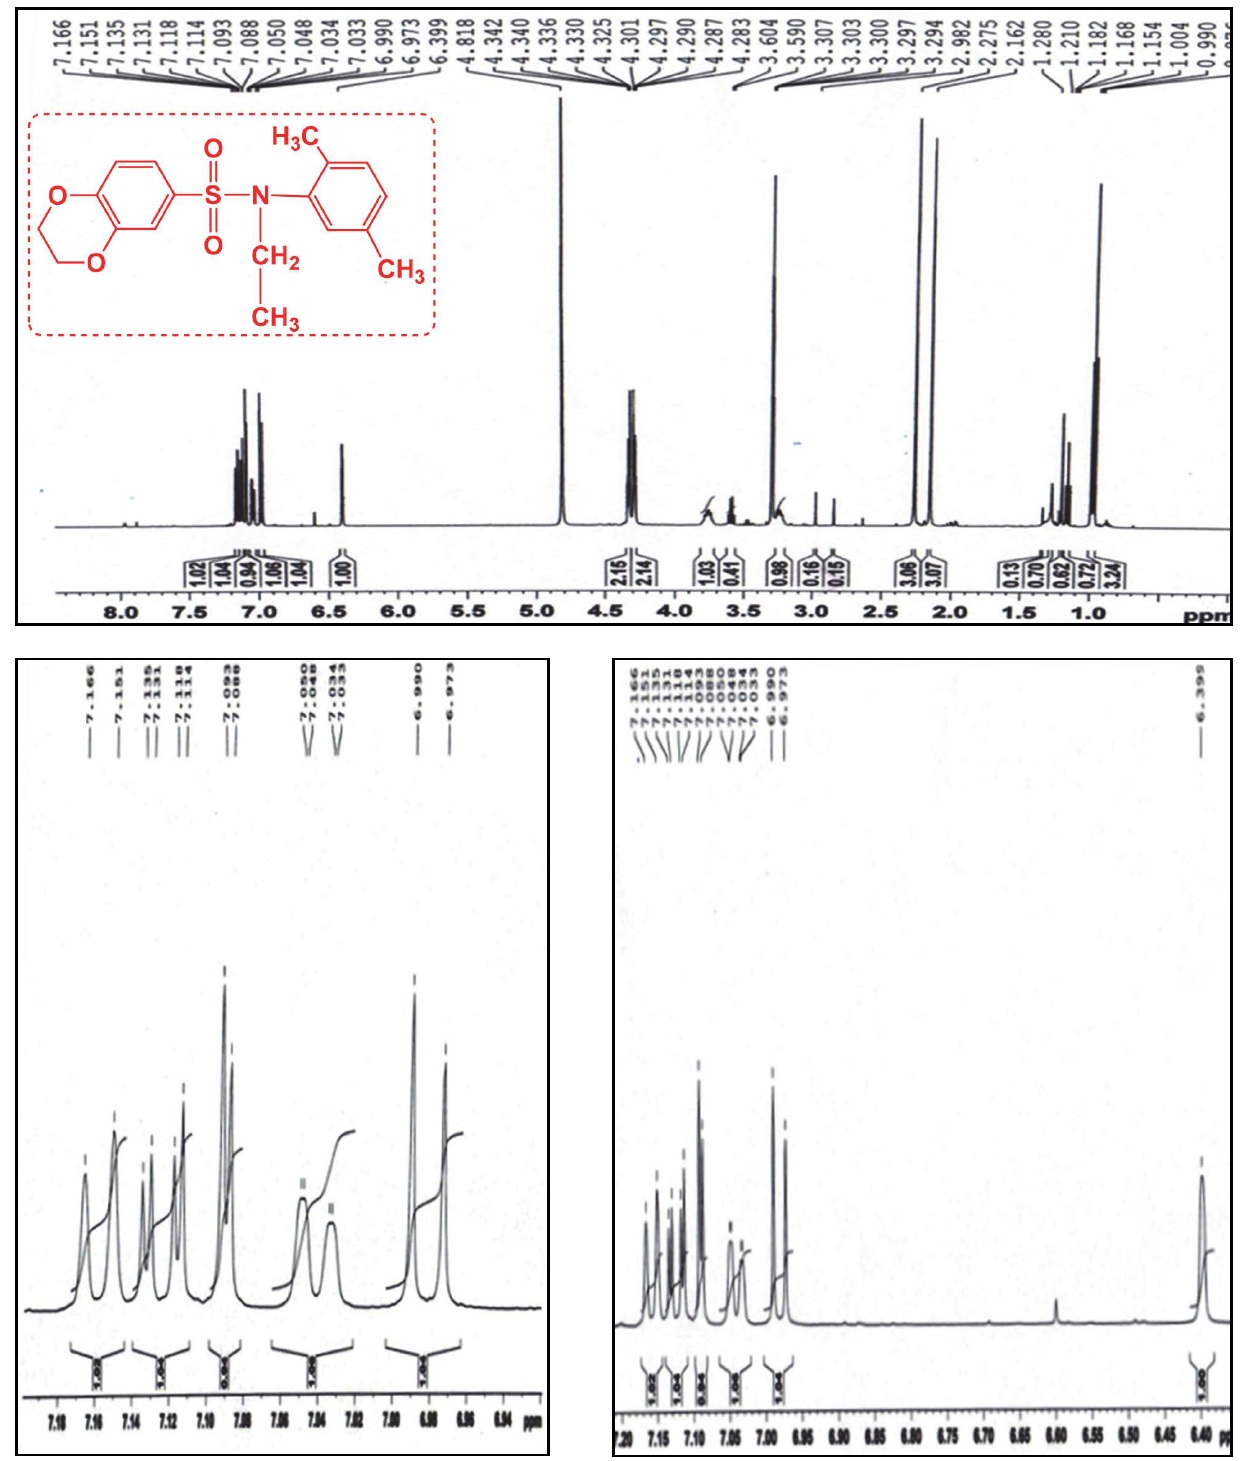
Figure 1a. 1 H NMR spectrum of N -(2,5-dimethylphenyl)- N -ethyl-2,3-dihydrobenzo[1,4]dioxine-6-sulfonamide 7c (aromatic